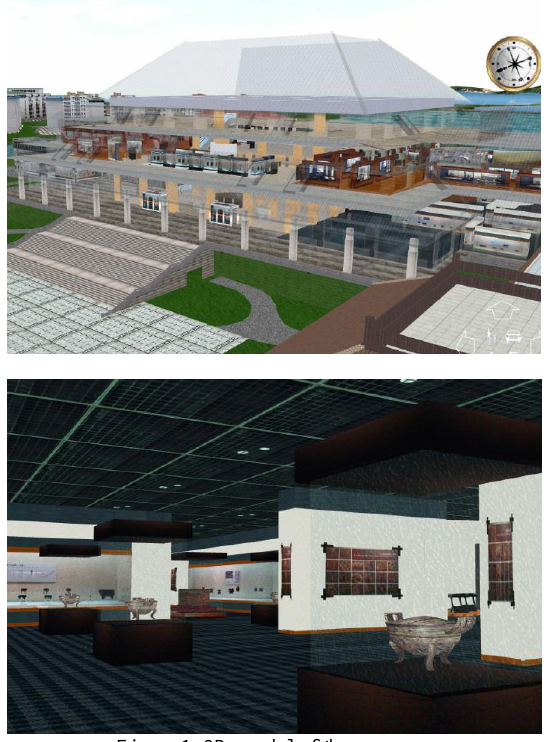
Figure 1. 3D model of the museum